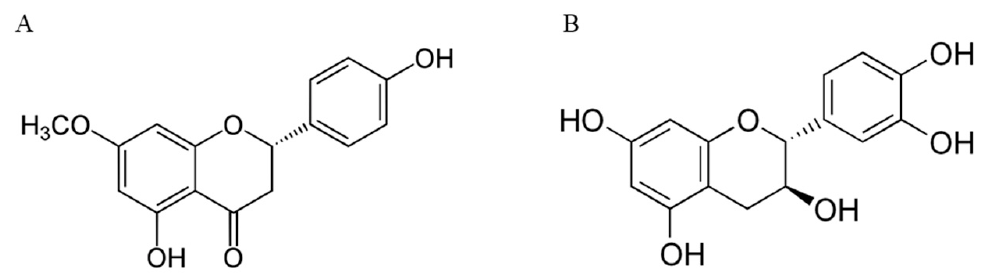
Figure 3. Chemical structure of sakuranetin ( A ) and catechin ( B ).